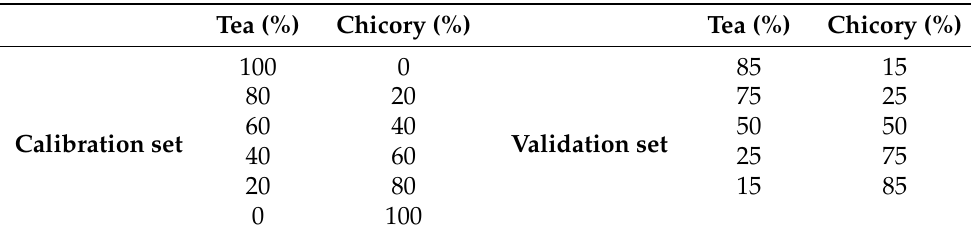
Table 2. Black or green tea and chicory blends used in the study of adulterations by PLS ( n = 5 for each